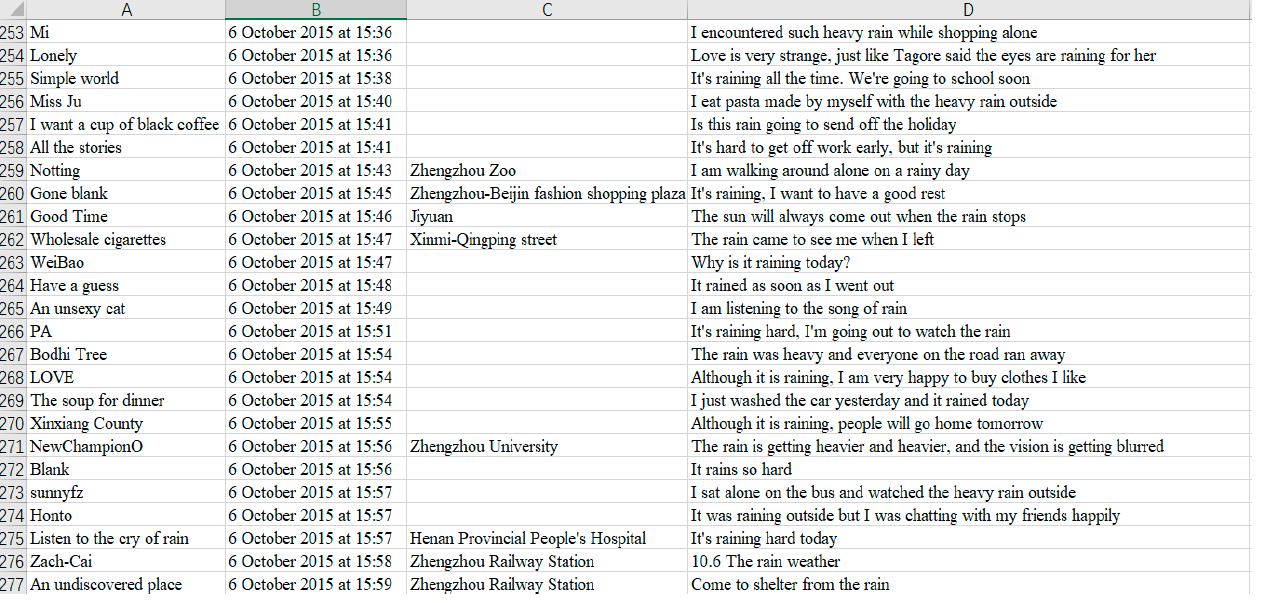
Figure 7. Part of the original unstructured